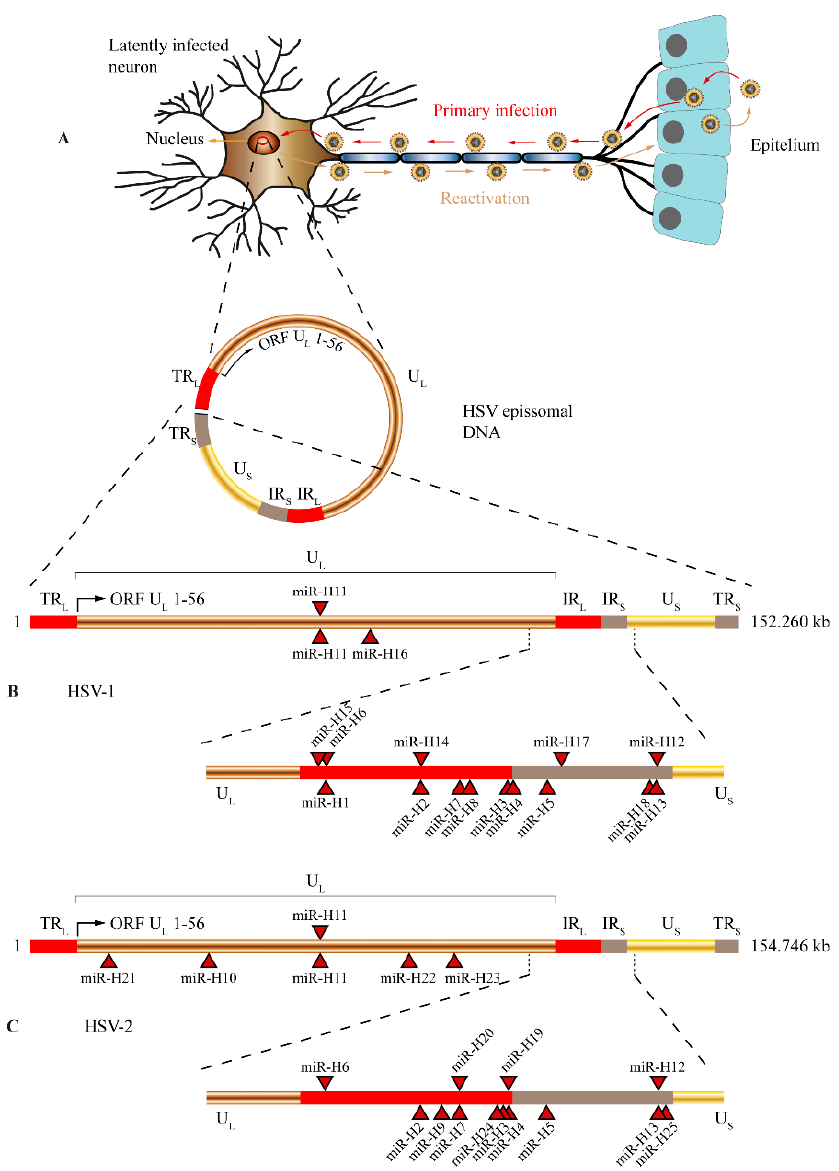
Figure 1. Viral genomic DNA structure and location of microRNAs (miRNAs) encoded by herpes simplex virus type 1 and type 2 (HSV-1 and HSV-2). ( A ) Episomal DNA in a latently infected neuron. After primary infection, HSV-1 or HSV-2 virions migrate from oral or genital mucosa to a sensitive neuron that enervates those tissues establishing a latent infection. The migration through neuronal dendrites occurs by a retrograde microtubule-associated transport, allowing HSV to reach nerve cell body. As a response to several exogenous or endogenous stimuli, the latent virus is reactivated and viral particles are anterograde transported to the mucosa where they infect epithelial cells allowing viral transmission. During latency, the HSV genome is maintained as a circular episome (represented as a red circle inside the nucleus). The structure and prototypic arrangement of the HSV episome is presented. U L (copper) and U S (gold) represent the long and short components of the viral genome. TR L and IR L (in red) represent the repeat sequences flanking U L and TR S , and IR S (in light brown) represent the repeat sequences flanking U S . Genomic location of miRNAs encoded by HSV-1 ( B ) and HSV-2 ( C ). A linear representation of both HSV-1 and HSV-2 genomes are shown, and the locations of miRNA precursors encoded by each virus are denoted by red triangles. The regions of the internal repeat sequences (IR L and IR S ) are expanded in the bottom of each genome. miRNAs shown below the line representing viral double-strand DNA are transcribed in an antisense direction (from left to right), while those shown above the line are transcribed in the opposite orientation.